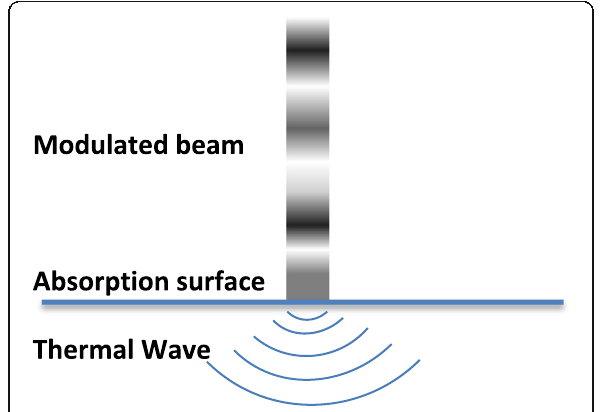
Fig. 1 Photothermal phenomena caused by illumination of a surface by modulated beam of the